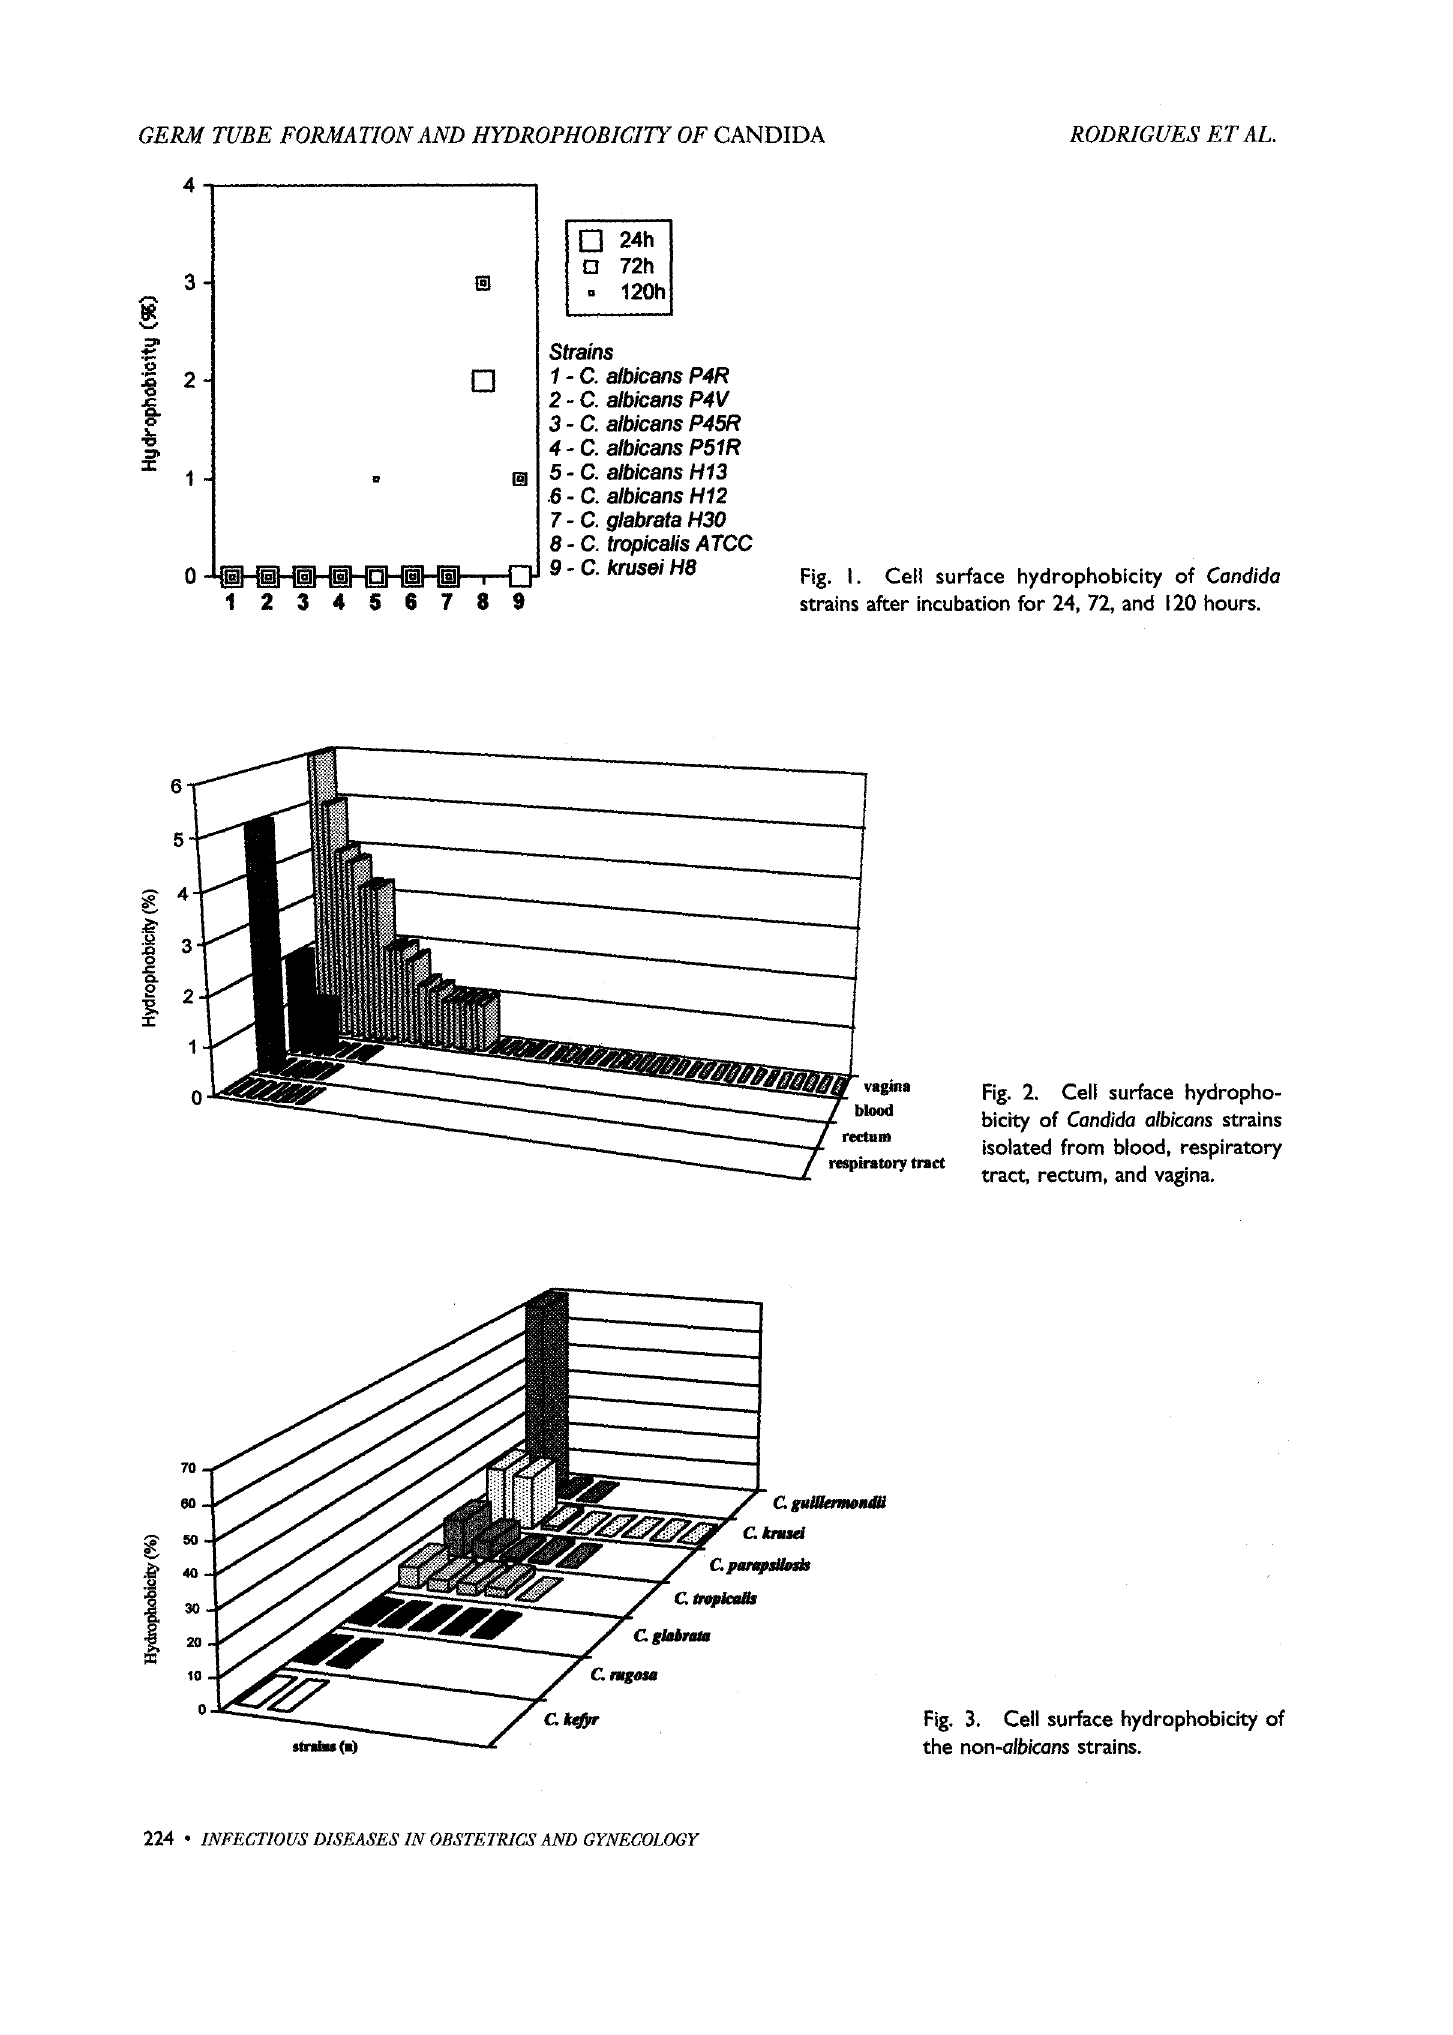
Fig. I. Cell surface hydrophobicity of Candida strains after incubation for 24, 72, and 120 hours.